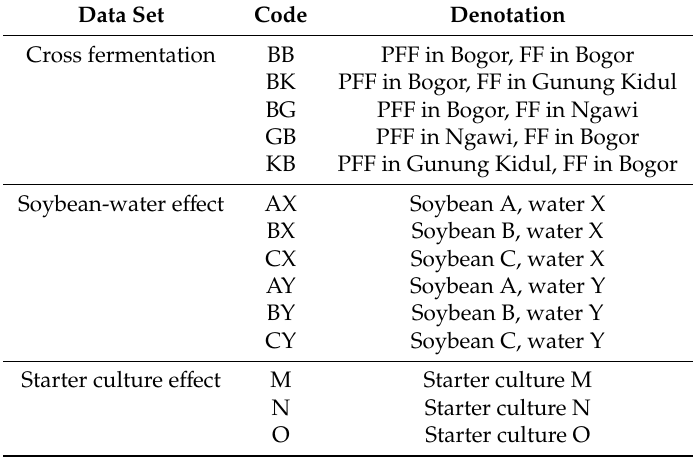
Table 1. Sample codes